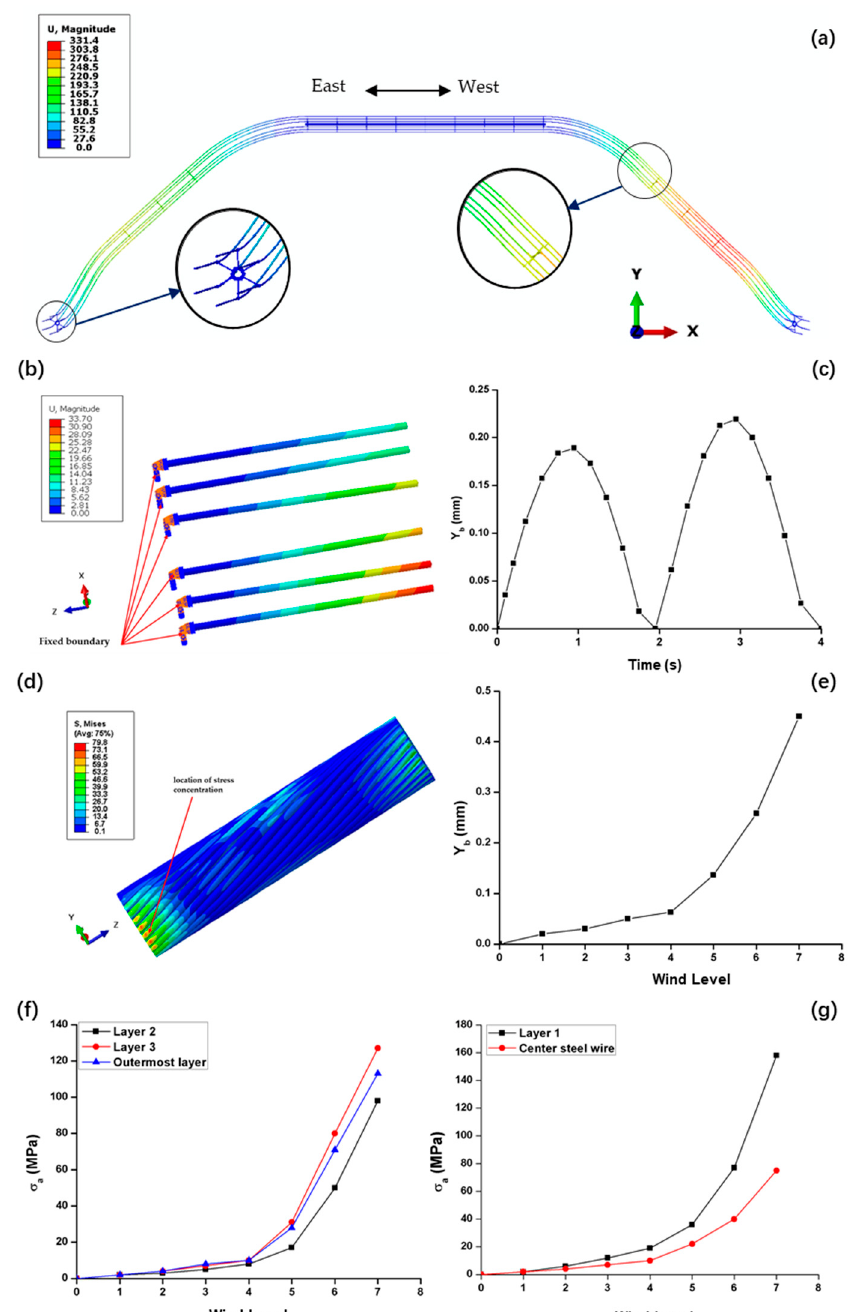
Figure 6. ( a ) Swing mode of the mid-phase jumper under the westerly wind, ( b ) the displacement nephogram of the whole model with a length of 1000 mm at the outlet of the tension clamp, ( c ) Y b value of the whole model under the level-6 wind, ( d ) stress nephogram of the local finite element model, ( e ) value of Y b corresponding to di ff erent wind loads, ( f ) σ a of three aluminum conductor layers model, ( e ) value of Y b corresponding to different wind loads, ( f ) σ a of three aluminum conductor corresponding to di ff erent wind loads, and ( g ) σ a of the corresponding steel layer under di ff erent layers corresponding to different wind loads, and ( g ) σ a of the corresponding steel layer under wind different wind loads.